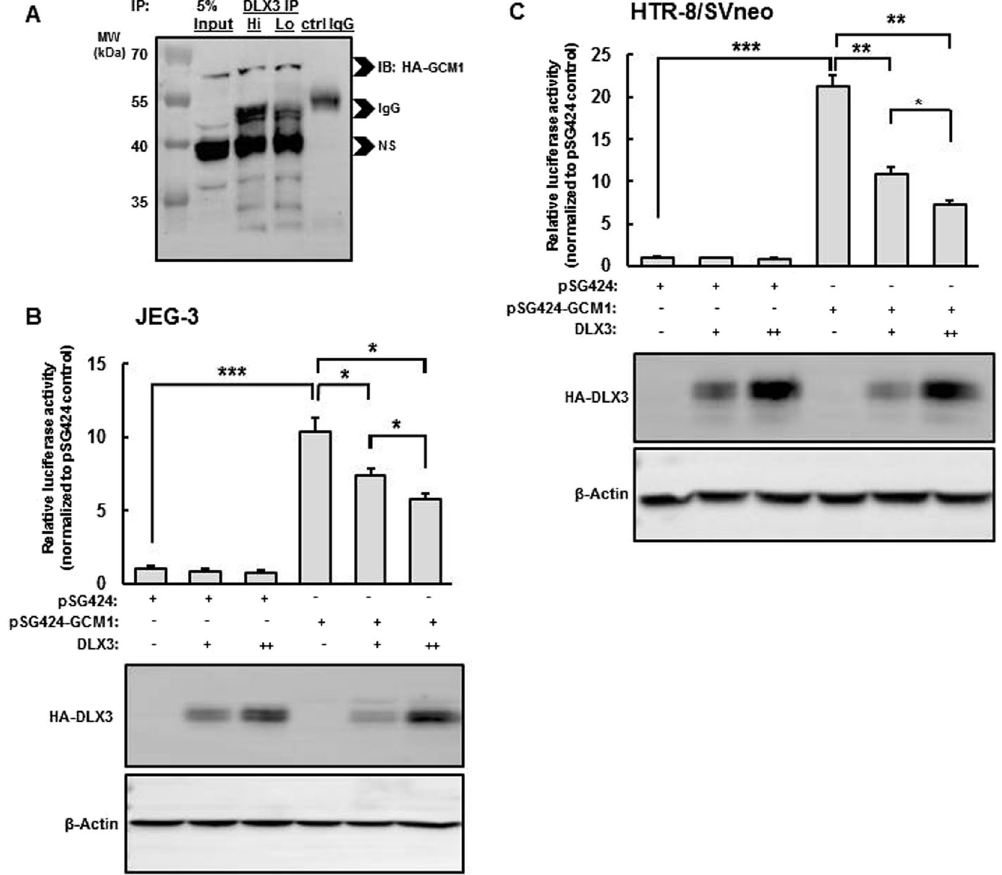
Figure 1. DLX3 physically interacts with GCM1 and inhibits the transcription-stimulating activity of GCM1. ( A ) JEG-3 cells transfected with the pHA-GCM1 for 48 h followed by 10 μ M MG-132 treatment for 6 h were collected for immunoprecipitation (IP) using the anti-DLX3 antibody used at two doses (Lo = 1.5 μ g/500 μ g protein and Hi = 3.0 μ g/500 μ g protein). IPs were subjected to immunoblotting and probed with the anti-HA antibody. Non-specific rabbit IgG isotype control antibody was used as the negative control for IP. This is a representative complete western blot film from three independent experiments is shown. Molecular mass ladder is shown to the left of the image. NS = non-specific. Mammalian one hybrid assays were performed in JEG-3 ( B ) and HTR-8/SVneo cells ( C ) transfected with pKH3-DLX3 (0.5 µ g or 1 µ g) and pSG424-GCM1(0.5 µ g; Gal4-GCM1) together with pGL4.31(0.5 µ g; luciferase reporter) for 48 h and subsequently collected for luciferase assays. In ( B , C ) HA-DLX3 protein levels are shown by western blot analysis using β -actin as a lane loading control. The complete blots can be seen in Supplementary Figure 1. Luciferase activity was normalized to protein concentration and to the pSG424 control (empty Gal4 plasmid). Results are presented as the mean ± standard error (SEM) of triplicates from an individual experiment representative of three independent experiments. Asterisks denote a statistically significant difference: * P < 0.05, ** P < 0.01, *** P < 0.001 by two- way ANOVA followed by the post-hoc Bonferroni